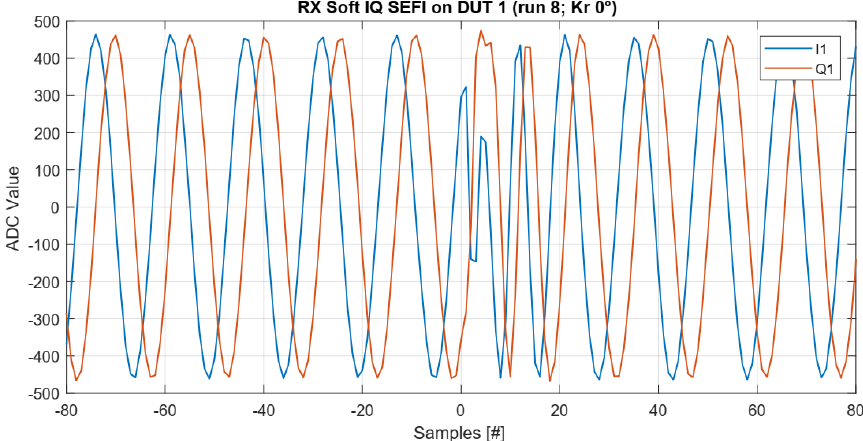
Figure 15. Soft IQ SEFI on channel 1 (I1 / Q1) of the DUT 1 receiver, showing a glitch in the data which recovers itself after 15–20 samples.